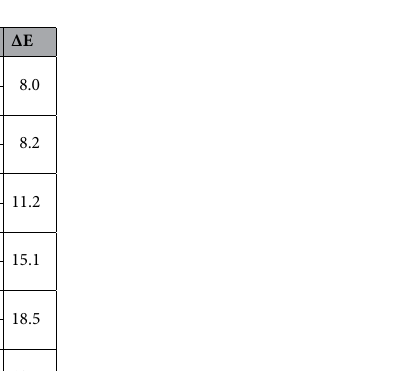
Figure 15. Photographs of dyed wool yarns ( a ) after and ( b ) before light colorfastness testing and their K/S curves.